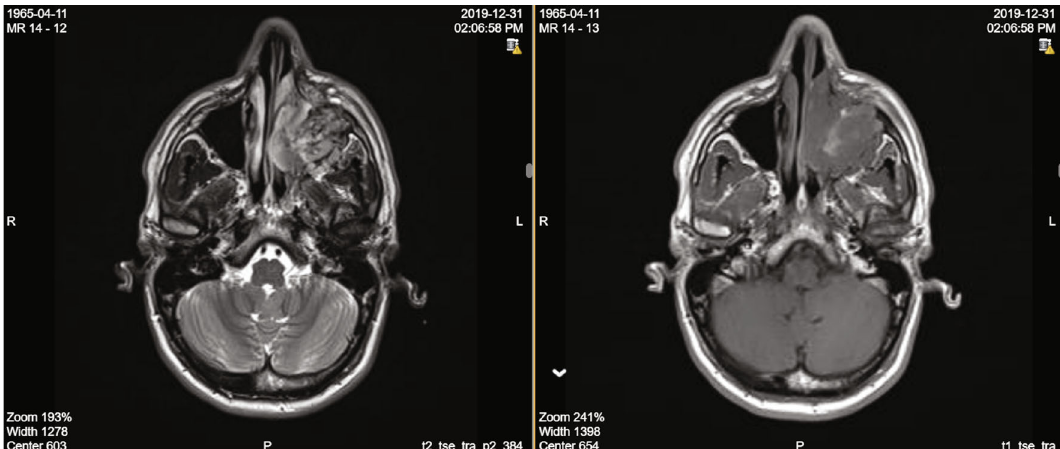
Figure 1: Orbital MRI images show a large mass occupying and destructing the left maxillary sinus with extension into the left nasal cavity and the adjacent retromaxillary